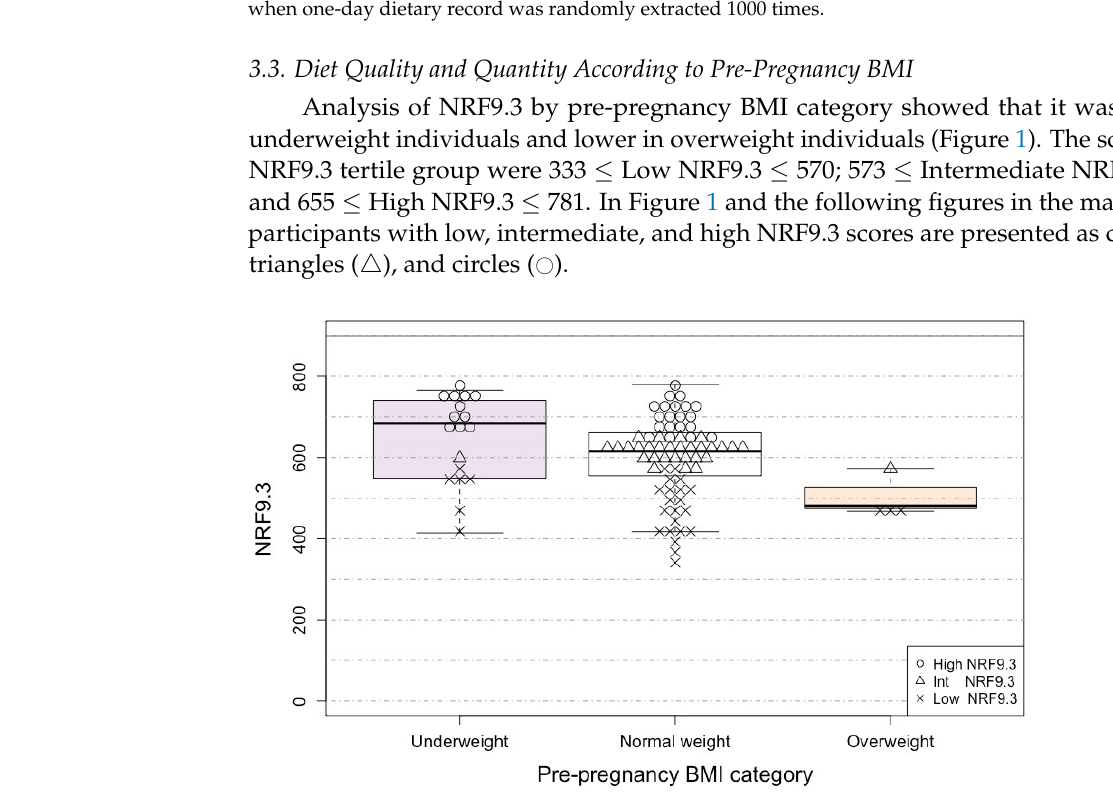
Figure 1. NRF9.3 by pre-pregnancy BMI category. Each subject ( n = 91) is shown in the box-and- whisker plots, with the boxes indicating the median and interquartile range and the whiskers denoting the range. Higher NRF9.3 scores indicate better overall diet quality. A maximum possible NRF9.3 score is 900 (solid line). Light purple, white, and pink indicate underweight, normal weight and overweight. Open circles, open triangles, and crosses indicate high, intermediate, and low NRF9.3 scores, respectively. NRF9.3, Nutrient Rich-Food Index 9.3; BMI, body mass index.